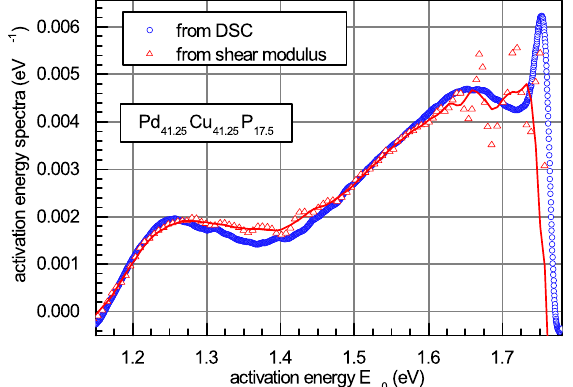
Figure 5. Activation energy spectrum of the structural relaxation of bulk glassy P d Cu P calculated using shear modulus and DSC data 41 : 25 41 : 25 17 : 5